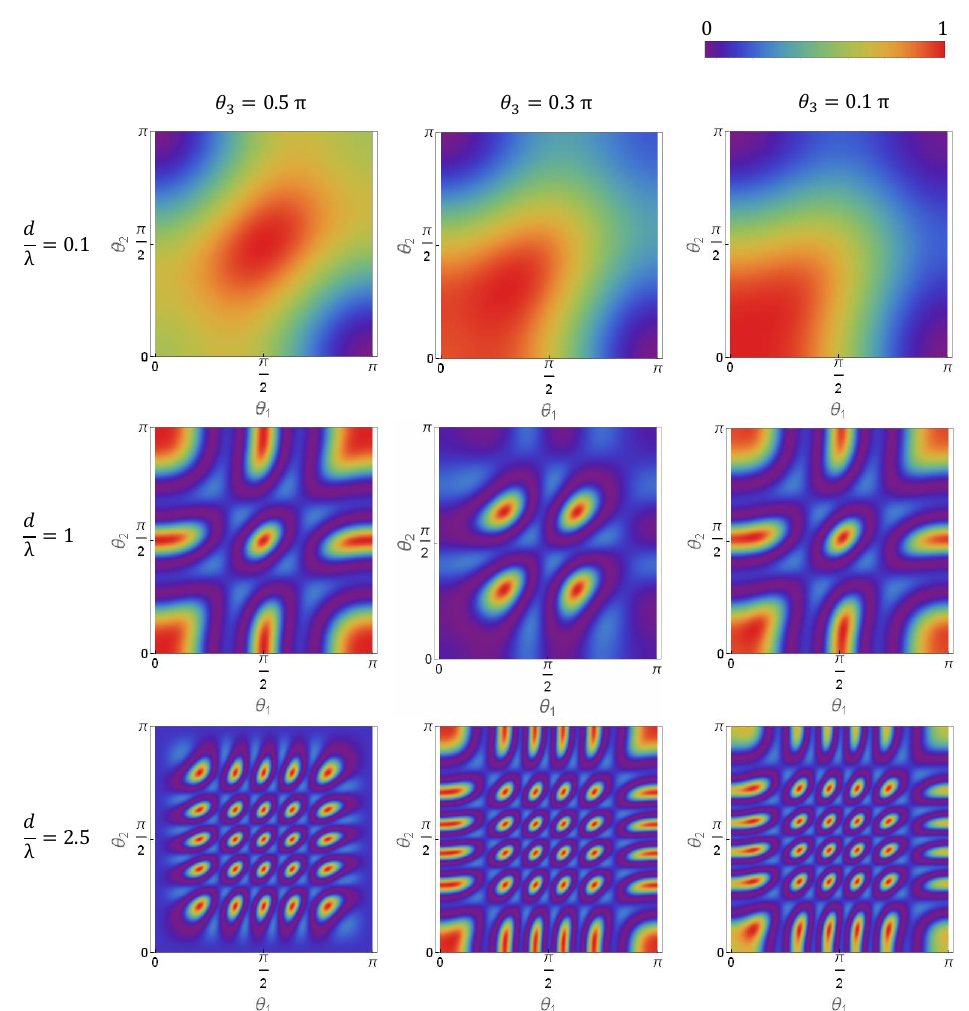
Figure 3. Quantum array factor (normalized to its maximum value) for different observation angles and emitter separation distances for a vertical linear array of N = 3 quantum emitters uniformly spaced along the Z-axis. The transition dipole moment of the emitters is assumed for the convenience to be oriented along the Z-axis, p = u z p , in order to make the quantum array factor depend only on the elevation angle θ . The normalized ( N = 3 ) -order quantum array factor, f 3 ( θ 1 , θ 2 , θ 3 ) , is explicitly shown as a function of θ 1 and θ 2 for different values of θ 3 : first column, θ 3 = 0.5 π ; second column, θ 3 = 0.3 π ; and third column, θ 3 = 0.1 π ; and as a function of the emitter separation distance d : first row, d = 0.1 λ 0 ; second row, d = 1.0 λ 0 ; and third row, d = 2.5 λ 0 , λ 0 being the wavelength at the transition frequency of the quantum